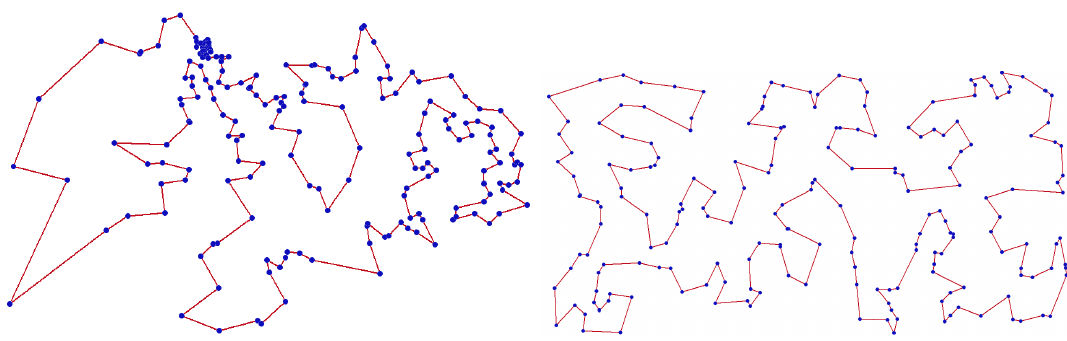
Figure 3. Optimal tour for qa194 and KroA200 instances